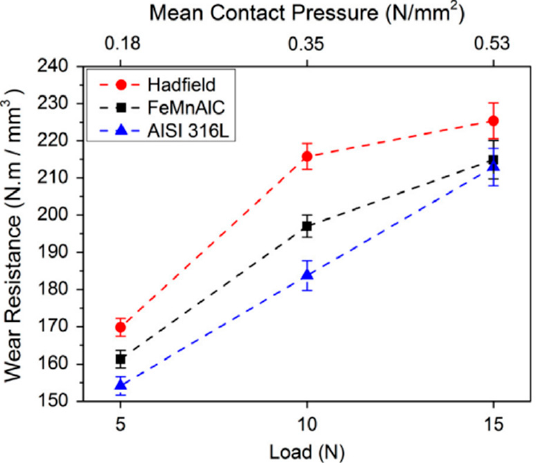
Figure 27. The effect of normal load on the wear resistance of the Fe-Mn-Al-C steel, Hadfield steel, and AISI 316L stainless steel (the bars correspond to the interval of confidence at 95%) [214]. (Reproduced with permission from refs. [214]. Copyright (2016), Elsevier).